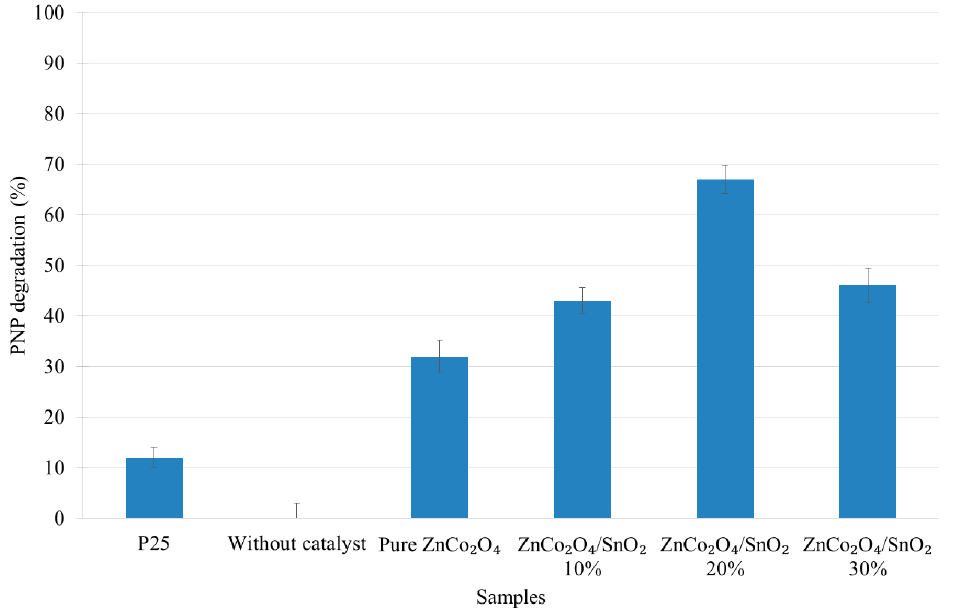
Figure 9. p -Nitrophenol (PNP) degradation (%) without catalyst and for all the samples under visible light after 24 h of illumination.